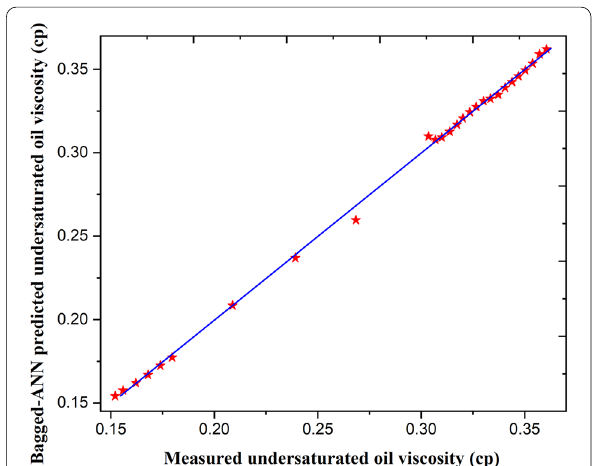
Fig. 10 Cross plot of bagged-ANN predicted values versus measured values